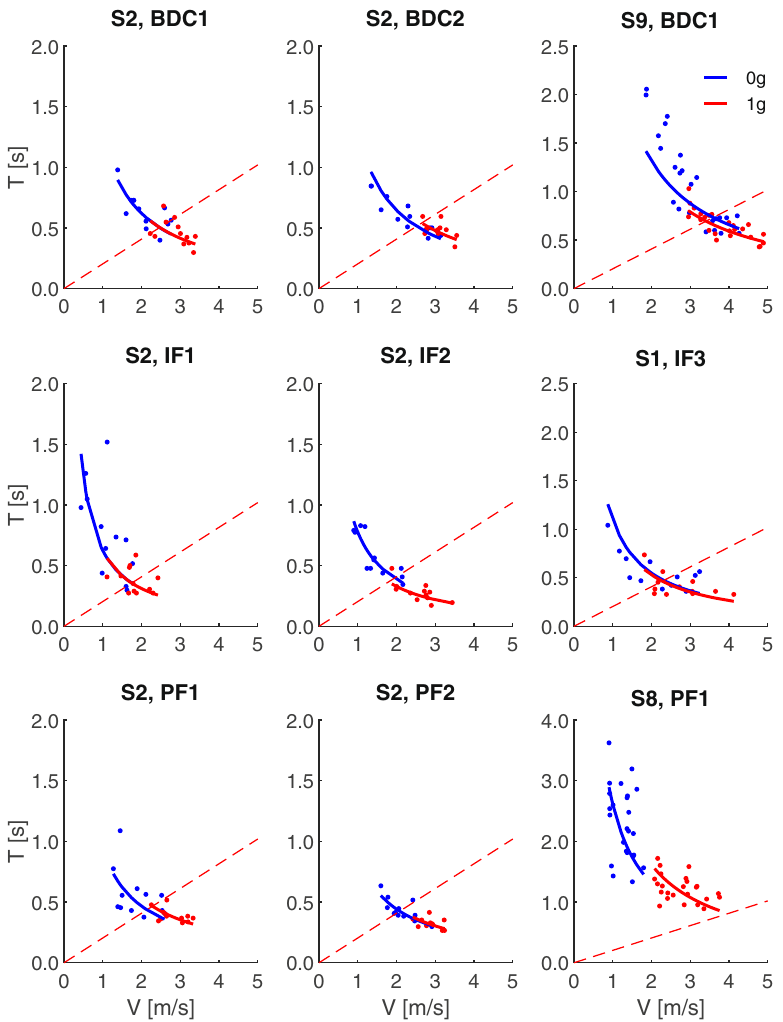
Fig. 2 Imaginary motion duration vs. throwing speed. Scatter plots of T , V values for all trials performed by participants S2, S9, S1, and S8, pre- fl ight, in- fl ight, and post- fl ight, with best- fi tting hyperbolic functions of imaginary 0 g (blue) and 1 g (red) data-points. Dashed curves correspond to T = 2 V/g